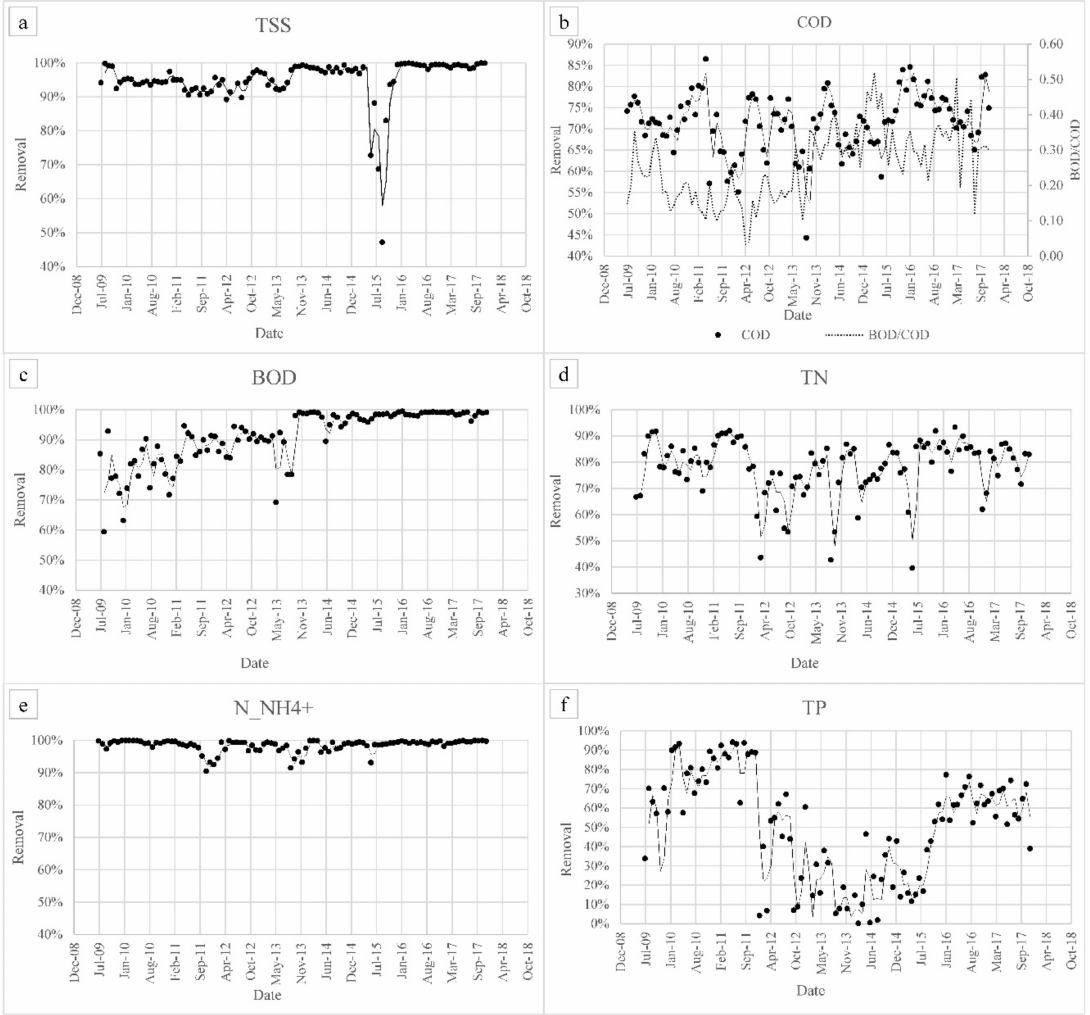
Figure 3. Efficiency of the side-stream plant from 2009 to 2017: ( a ) total suspended solids (TSS), ( b ) Chemical Oxygen Demand (COD), ( c ) Biological Oxygen Demand (BOD 5 ), ( d ) total nitrogen (TN), ( e ) (N_NH 4+ ) and ( f ) total phosphorus (TP) removal